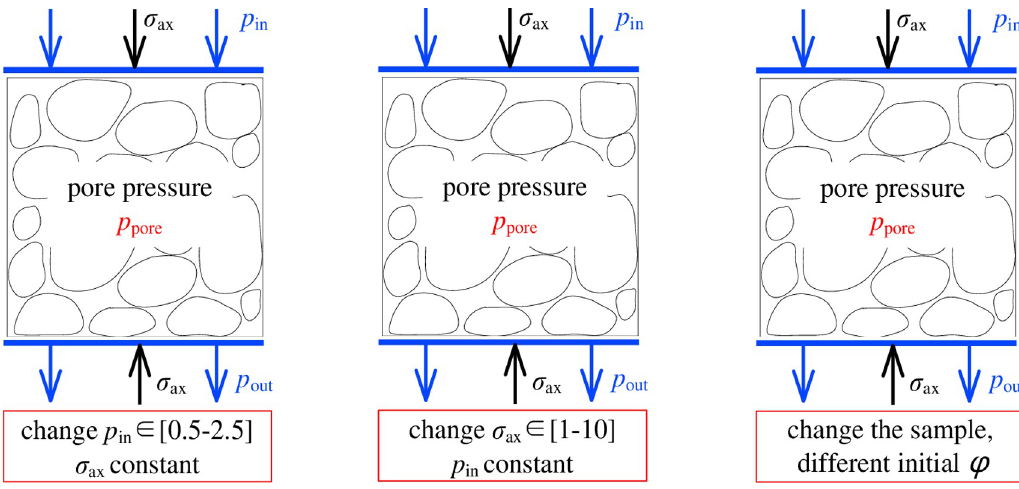
Where: σ stands for the stress acting on the whole porous medium, called total stress, MPa; σ o stands for the stress acting on the solid particles, P called effective stress, MPa; it stands for P the pressure of the fluid in the pore, called pore pressure, MPa. mainly used in the field of foundation engineering. Three different test states of pore structure specimens are shown in Fig 8. So far, the continuous improvement of the effective stress calculation formula has been car- ried out through the joint research of experts in this field. Finally, Heymann et al. [32] explained the stress relationship subjected to porous media considering both skeletal effective stress and structural effective stress and gave an expression for the effective stress true stress.